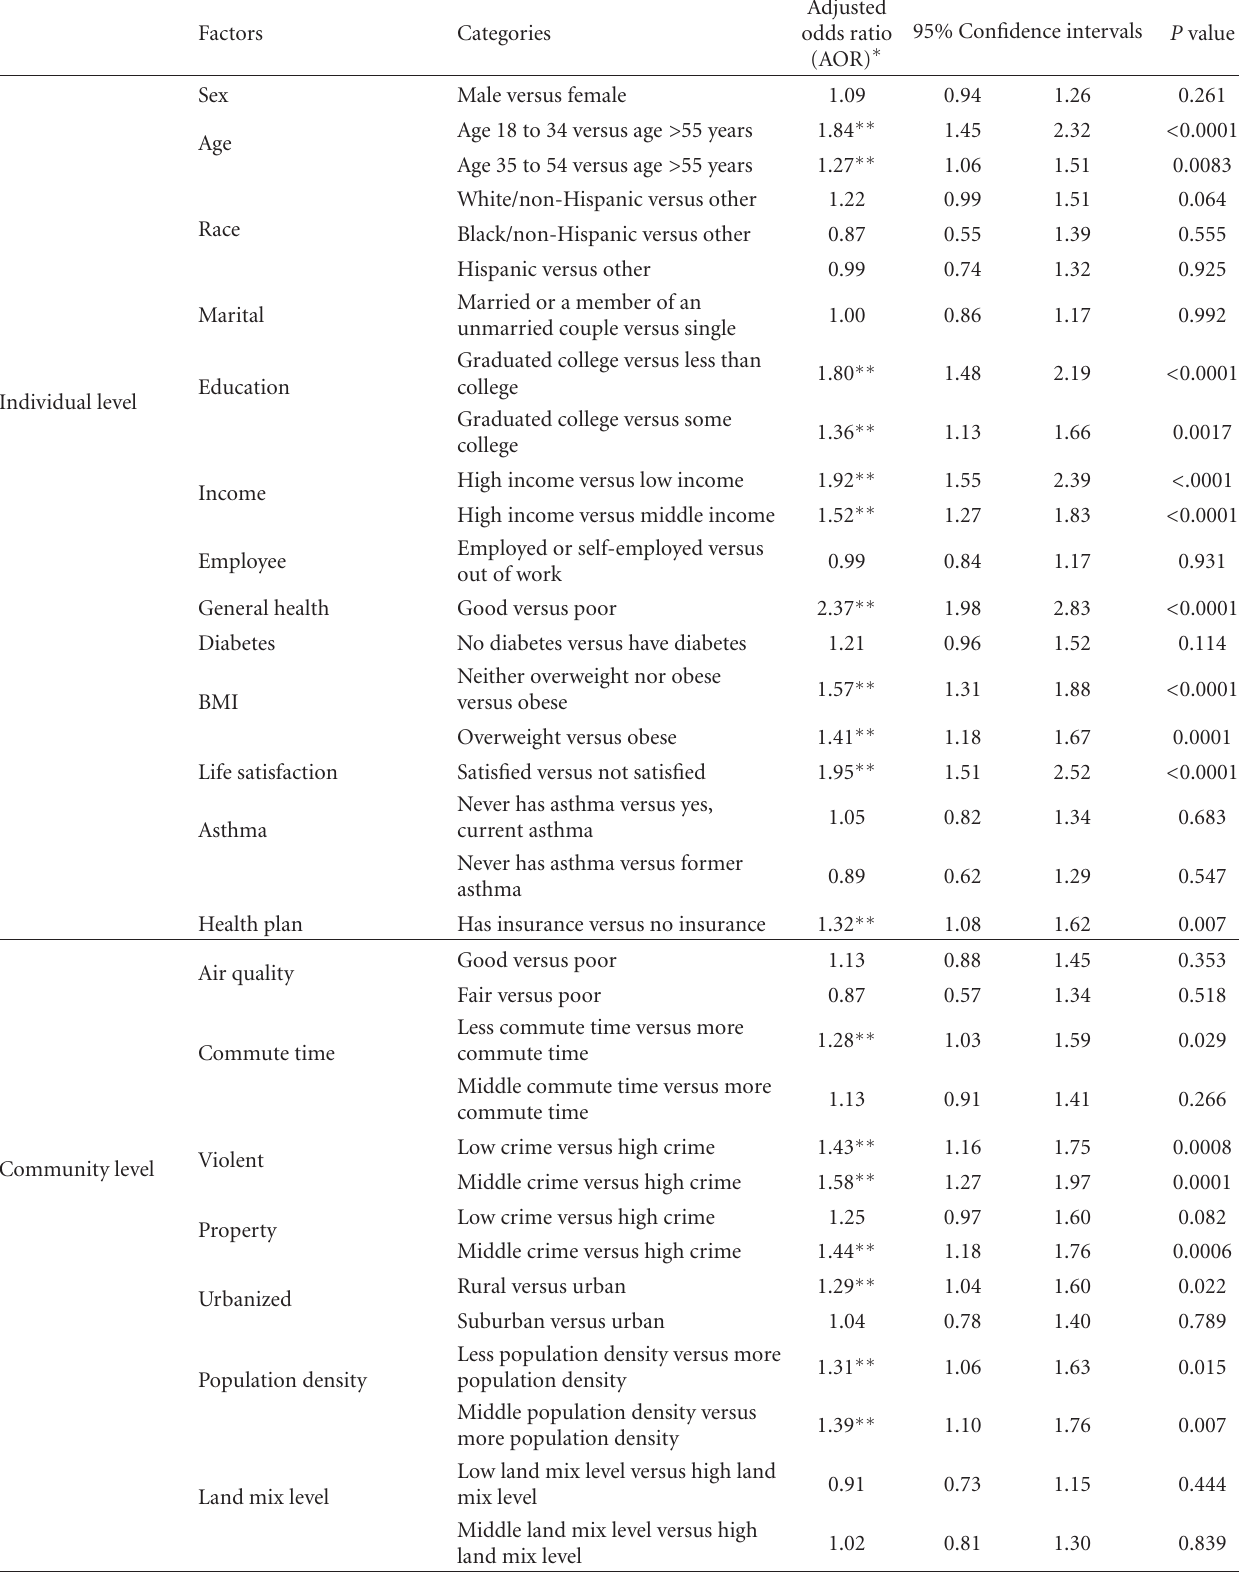
Table 3: Adjusted odds ratio for factors related to conducting leisure time physical